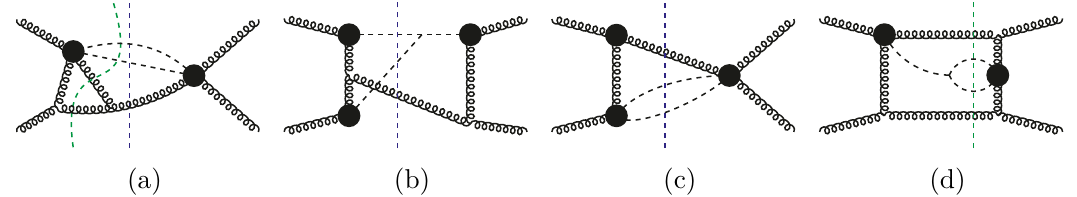
Figure 3 . The forward-scattering diagrams of figure 2, with black circles representing the expanded hard subgraphs in the large- m expansion. Three- and four-particle cuts are shown by blue and t green dashed lines,